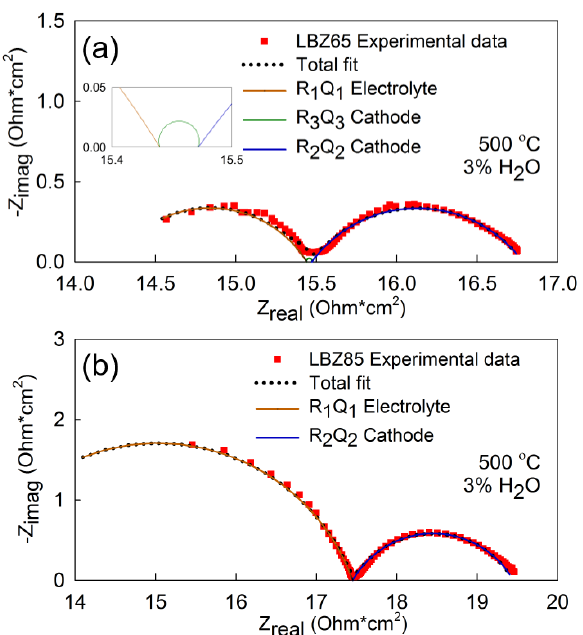
Figure 8. Nyquist plot of ( a ) LBZ65 and ( b ) LBZ85 symmetrical cells with screen printed composite cathodes in synthetic air with p(H 2 O) = 0.03 atm at 500 °C. The inset in (a) shows the magnification of R3Q3 fitting. The symbols correspond to the experimental data and the solid and dotted lines to the fits. The equivalent circuits used for fitting are (a) LRs(R 1 Q 1 )(R 3 Q 3 )(R 2 Q 2 ) and (b) LRs(R 1 Q 1 )(R 2 Q 2 ).